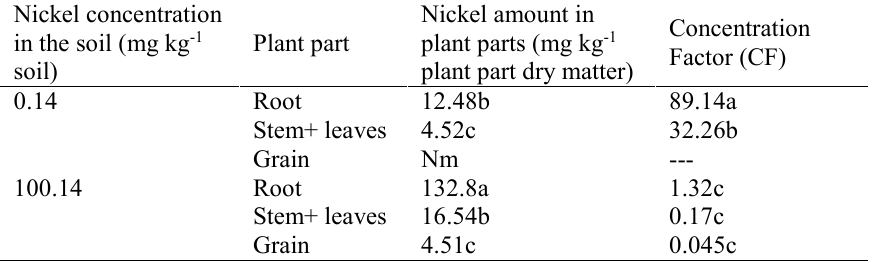
Table 2. Effect of nickel concentration in the soil on accumulation of nickel in wheat parts Nickel concentration Nickel amount in Concentration in the soil (mg kg -1 Plant part plant parts (mg kg -1 Factor (CF) soil) plant part dry matter) 0.14 Root 12.48b 89.14a Stem+ leaves 4.52c 32.26b Grain Nm --- 100.14 Root 132.8a 1.32c Stem+ leaves 16.54b 0.17c Grain 4.51c 0.045c Nm: not measured because of negligible amount; different letters in each column indicate Significant difference at P≤0.01